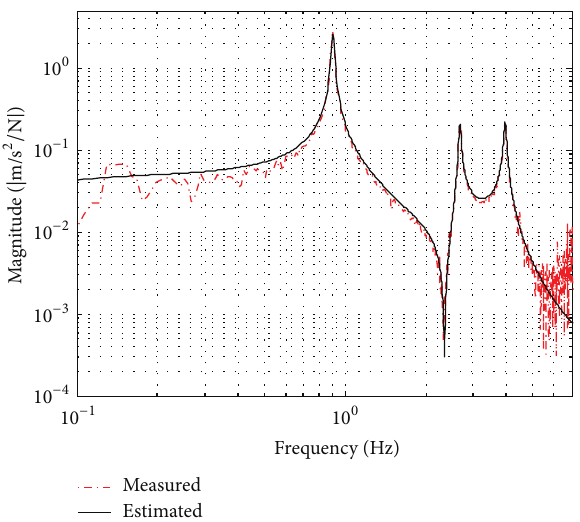
Figure 11: Comparison of the magnitude of frequency response functions (accelerances) for the second floor acceleration.